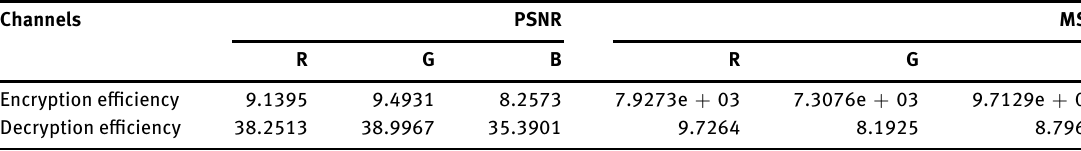
Table 4: Encryption Time of R, G, and B Components.